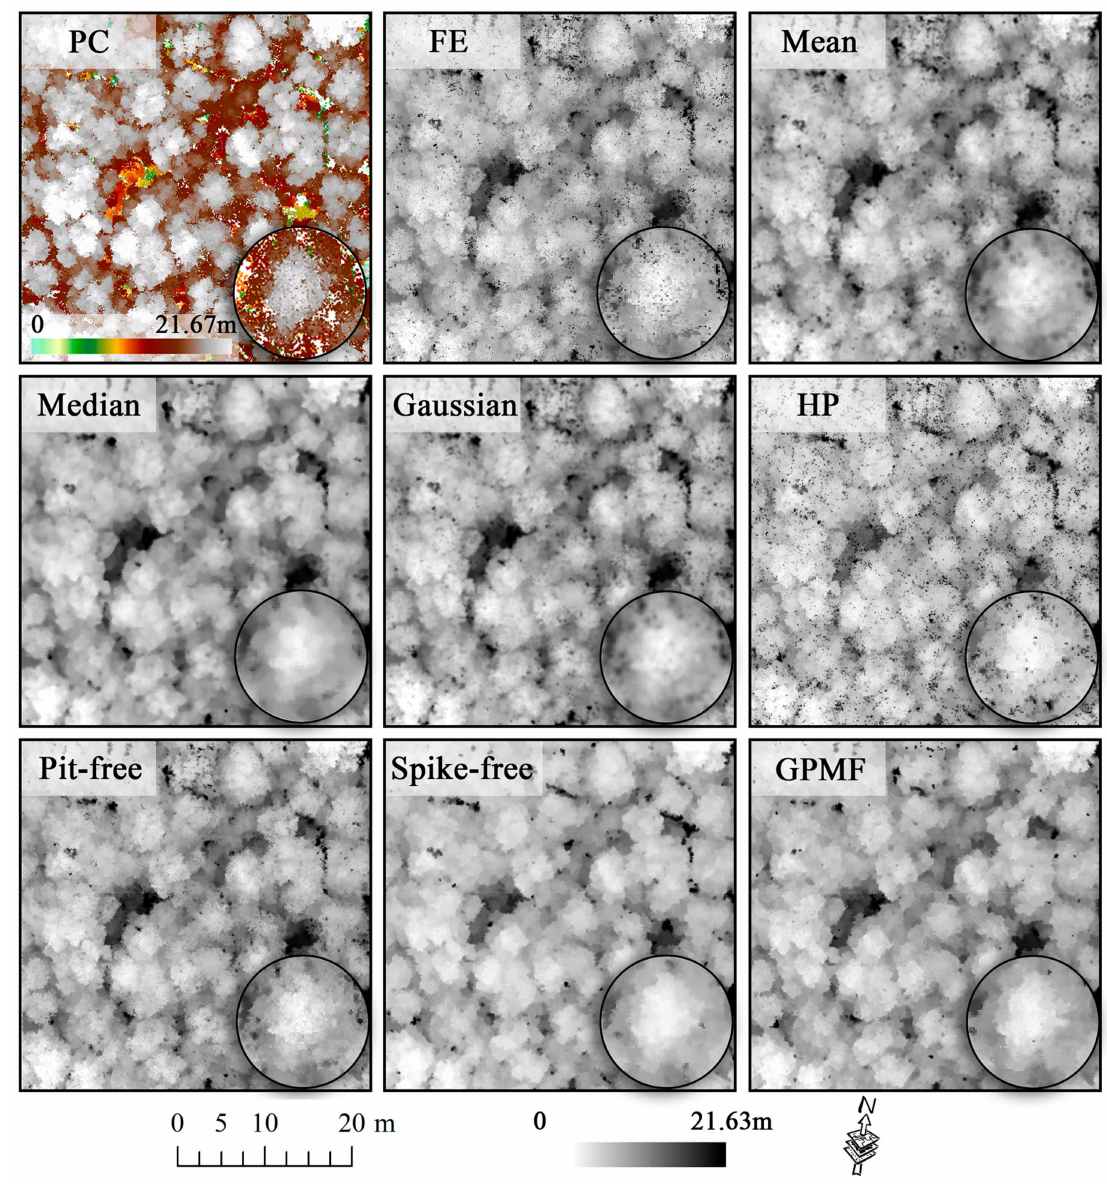
Figure 6. Visual comparison between CHMs generated by different methods and UAVLS normalized point clouds